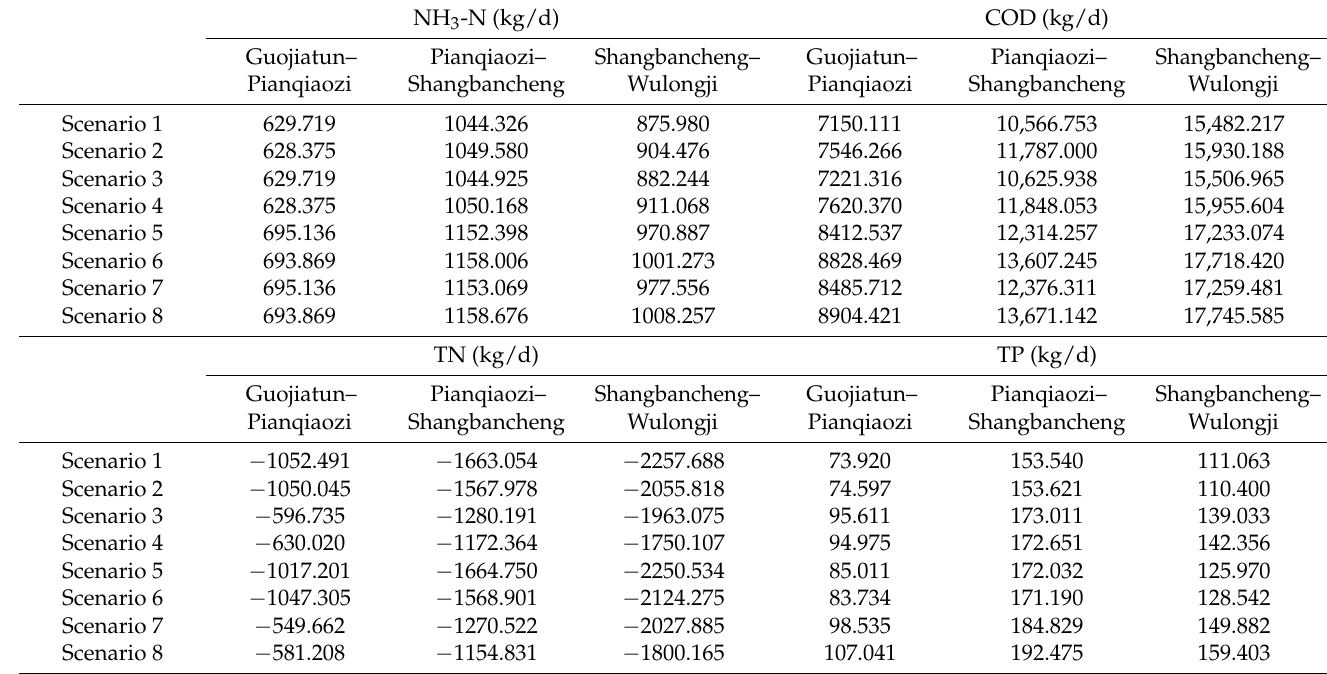
Table A3. Water environmental capacity of NH3-N, COD, TN, and TP in the main stream of Luanhe